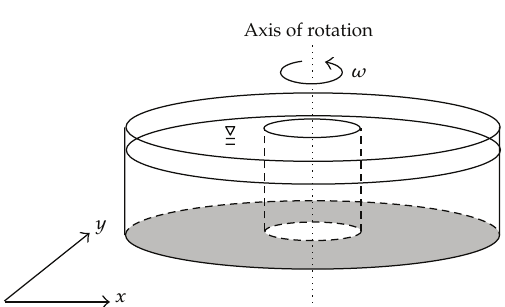
Figure 5: Rotating water in coaxial cylindrical container.